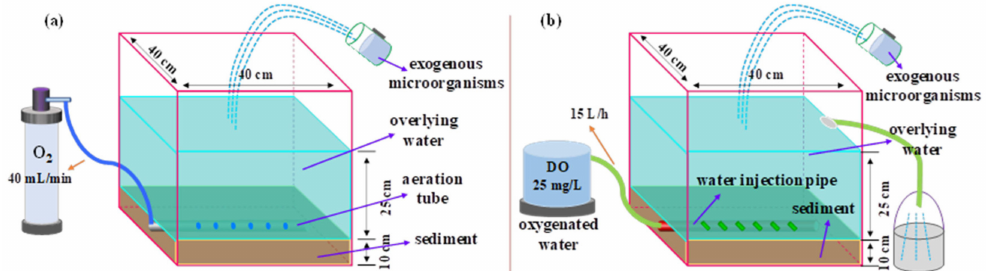
Figure 2. Schematic diagrams of ( a ) pure oxygen aeration treatment and ( b ) oxygen enriched water injection